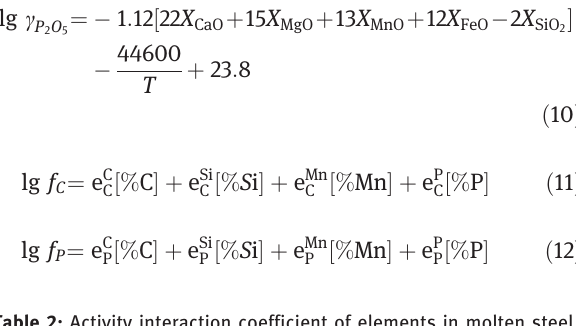
Table 2: Activity interaction coefficient of elements in molten steel [19 – 21]. e Si e C C C